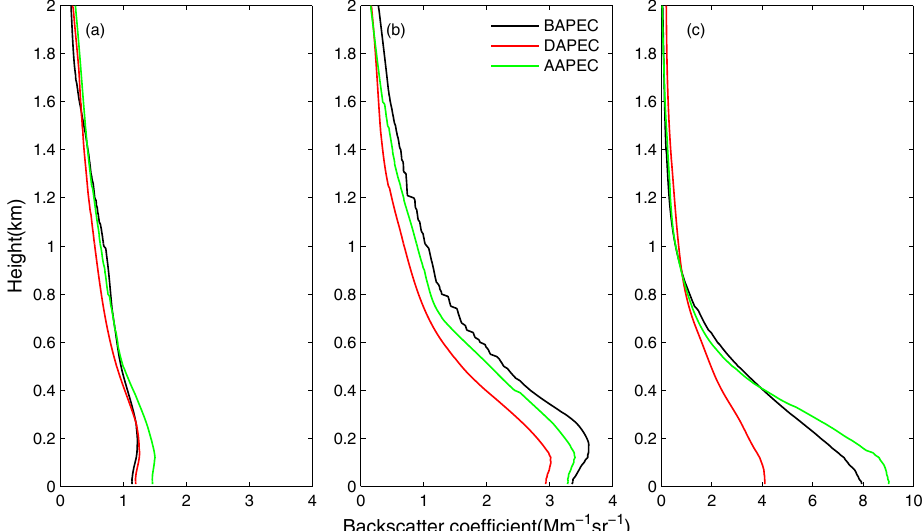
Figure 8. Attenuated backscattering profiles under different air pollution conditions during BAPEC, DAPEC and AAPEC: (a) PM < 50µgm − 3 , (b) 50µgm − 3 < PM < 100µgm − 3 , (c) PM > 100µgm − 3